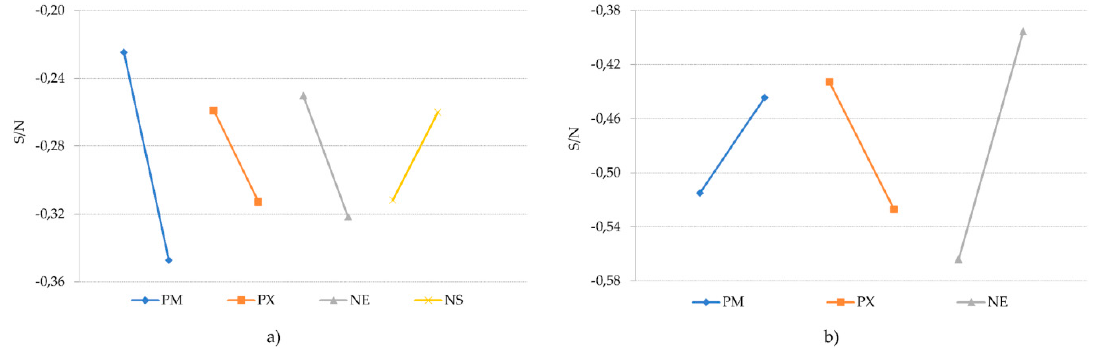
Figure 4. Relative importance of control parameters: ( a ) for stations locations optimization and( b ) for line layout optimization.